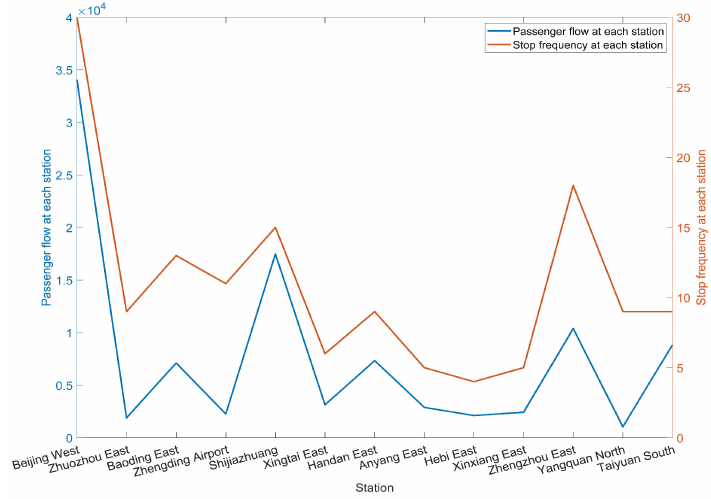
Figure 13. The correlation between passenger demand and stop frequency at each station.